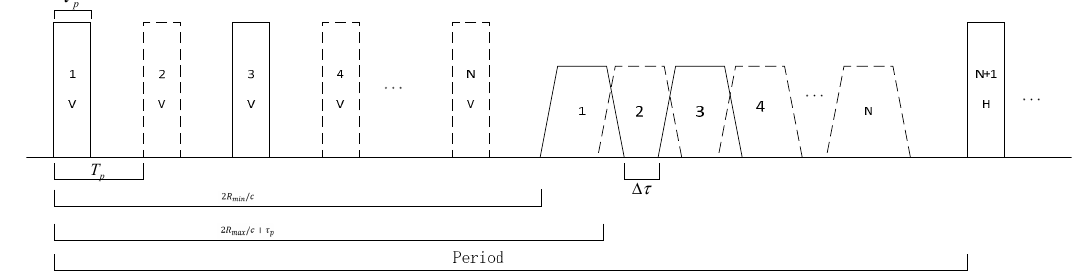
Figure 12. The modified pulse sequence.